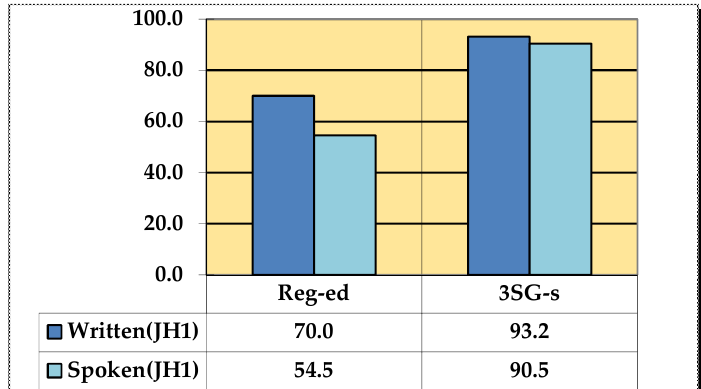
Figure 5. Omission rates of − ed and − s in obligatory contexts (%).